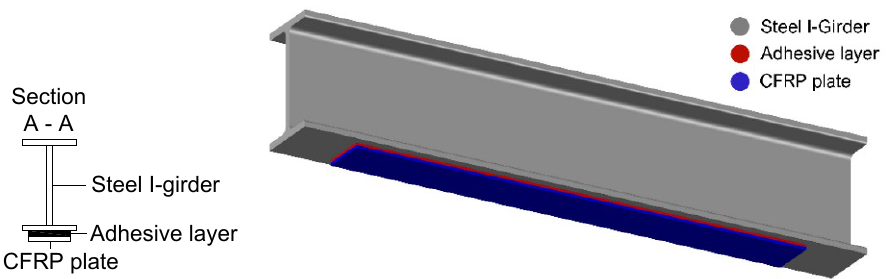
Figure 3. A typical sample of CFRP-reinforced steel I-girder.